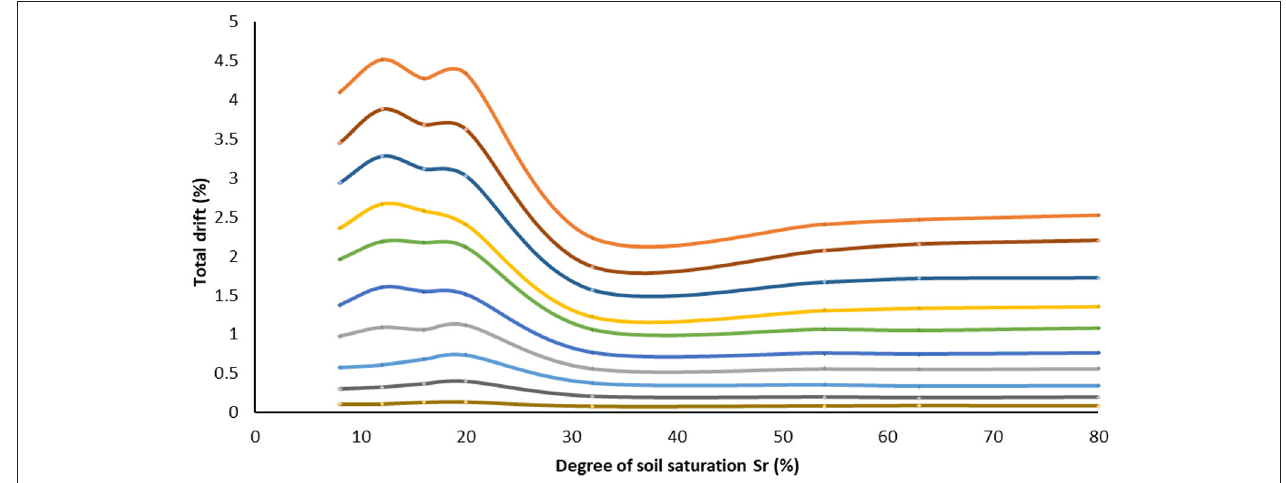
FIGURE 8 | Building in its initial state: total drift as a function of soil saturation level for the 10 scaling steps. Curves present median values of the MSDA